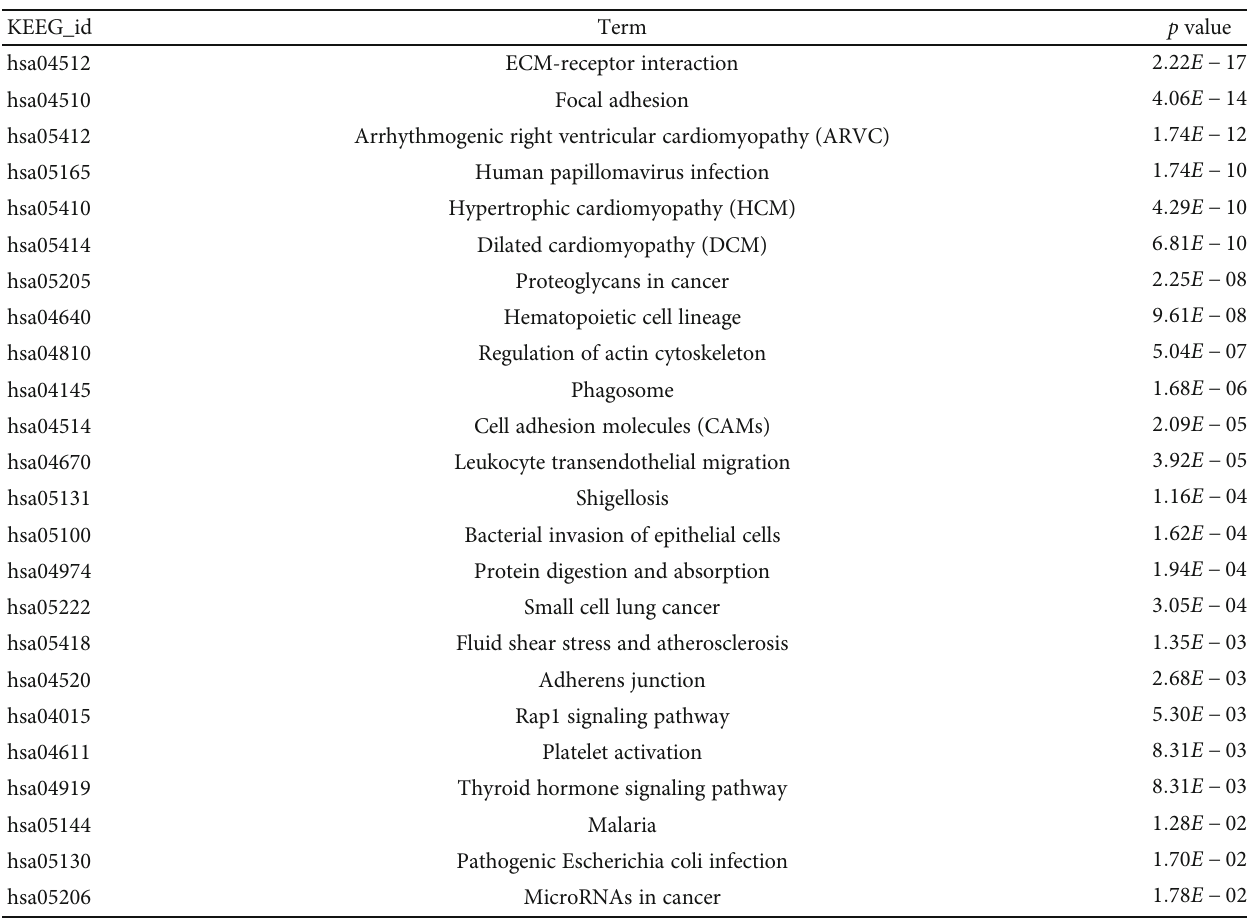
Table 2: KEGG pathways associated with biotinylated proteins overexpressed in cardiac progenitor/stem and bone marrow mesenchymal stem